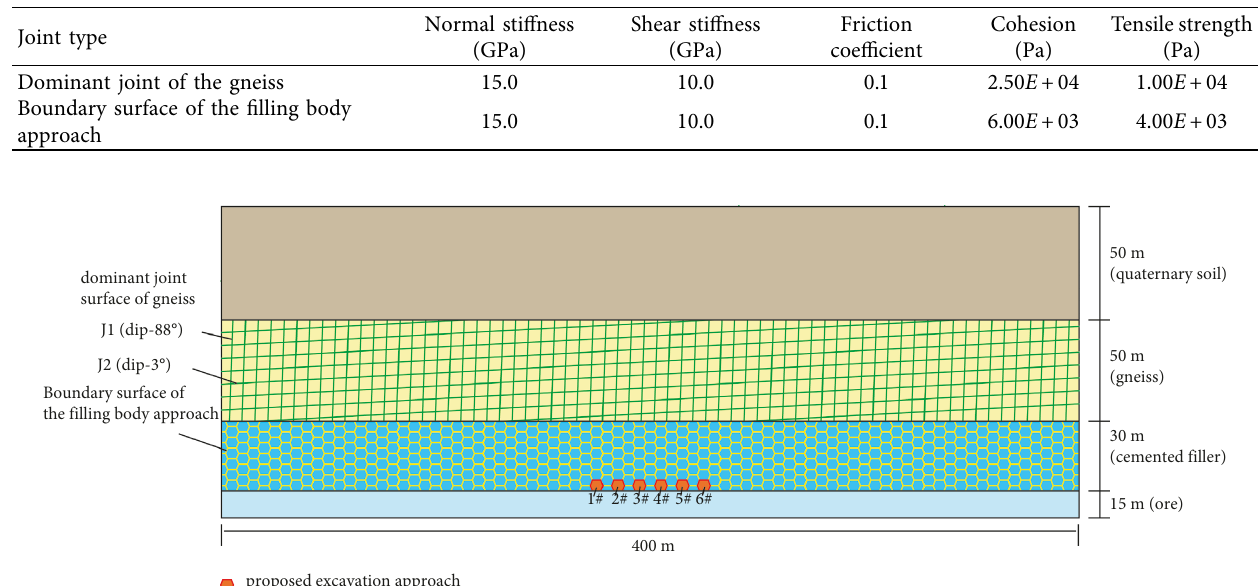
Table 3: Microscopic parameters of the joints.